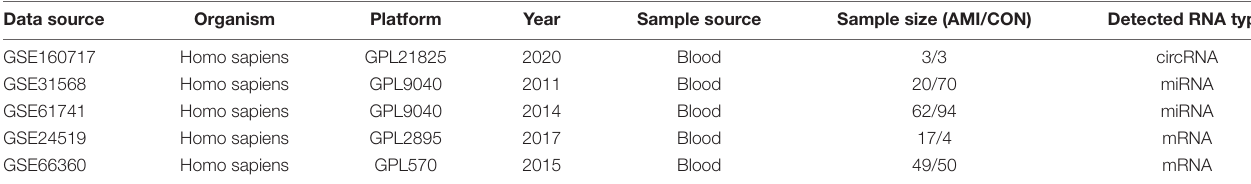
TABLE 1 | The detailed information of the 5 microarray